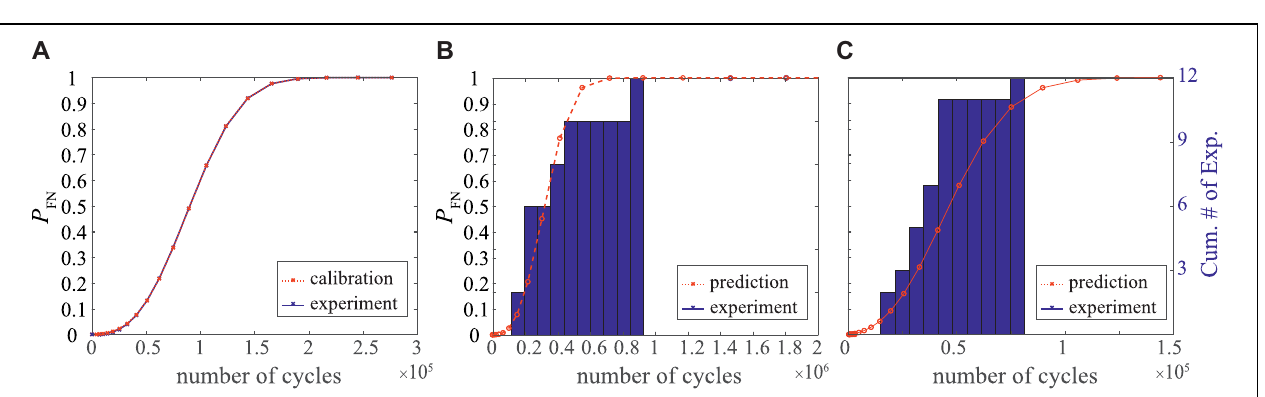
FIGURE 8 | Temporal evolution of (A) the scale parameter and (B) the shape parameter.